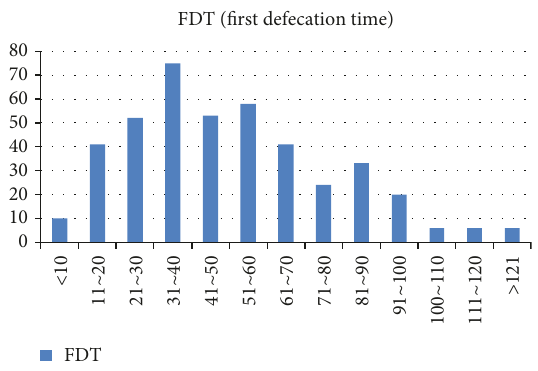
Figure 2: Minutes to the fi rst defecation time.